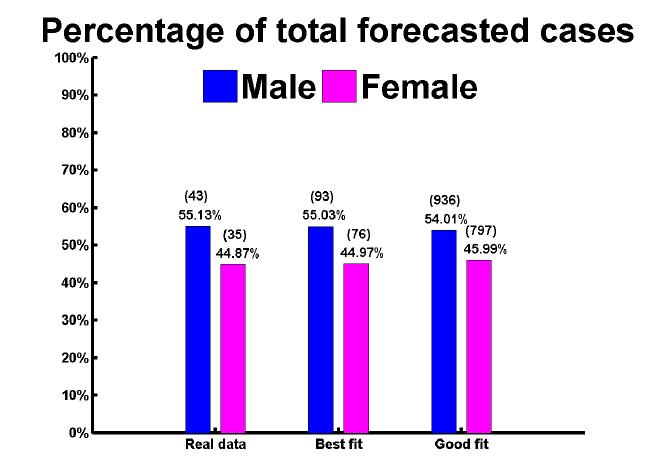
Figure 5. Infection percentage comparison between Males and Females for real data and both best and good